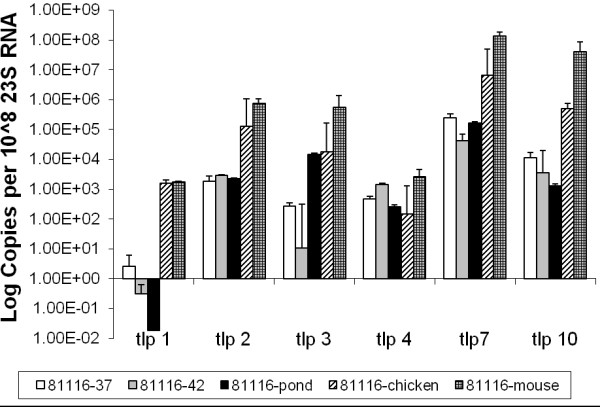
Expression of Group A tlp genes for C. jejuni strain 81116. Relative gene expression profiles of Group A tlp genes for C. jejuni 81116 grown at 37°C, 42°C, maintained in pond water and isolated in vivo from chicken and mouse. Expression is standardised and the scale is shown in log (copies per 108 of 23 S RNA). 37: grown under laboratory conditions at 37°C, 42: grown under laboratory conditions at 42°C, pond: maintained in an environmental water source at room temperature, 22°C, chicken: directly isolated from chicken caecal content by Dyna-beads, mouse: directly isolated from mouse intestines by Dyna-beads. Standard errors are shown as bars above the mean of a minimum of 3 independent PCR reactions.